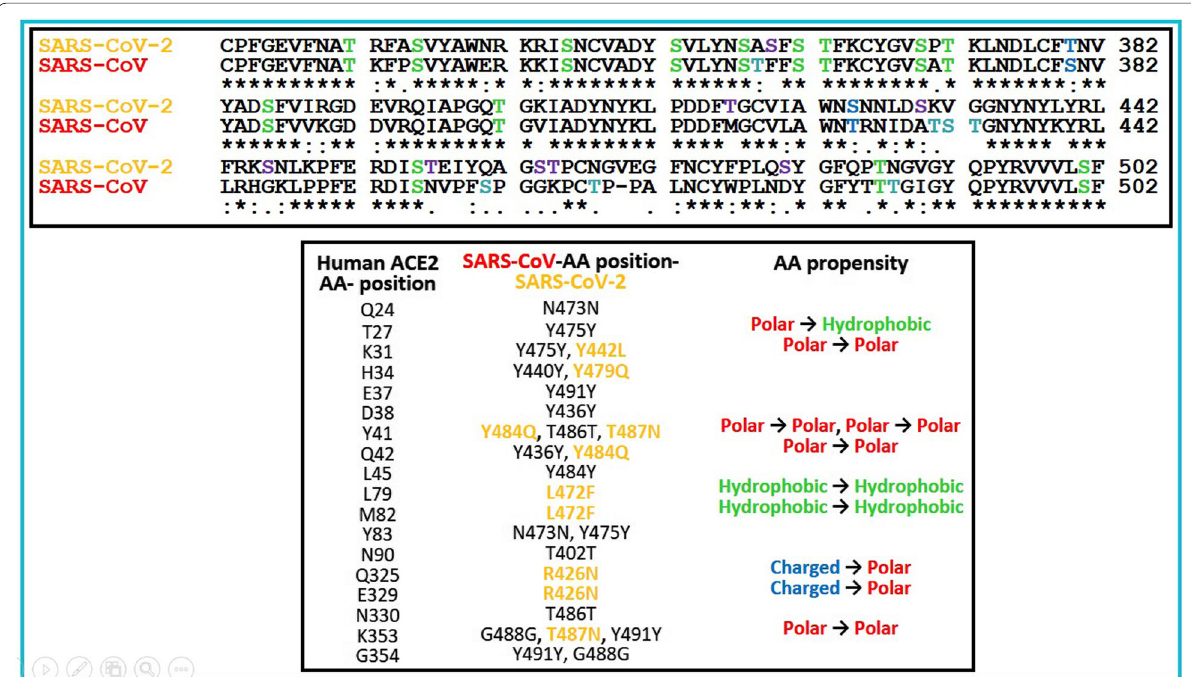
Fig. 3 Sequence alignments and characterization of SARS-CoV-2 RBD. a Amino acid alignment for RBD of SARS-CoV-2 and SARS-CoV. Highlighted residues: green, conserved Ser/Thr between two sequences; blue, conserved substitution; pink, new Ser/ Thr residues introduced in SARS-CoV-2; sea green, Ser/Thr residues in SARS-CoV replaced by other amino acids in SARS-CoV-2. b Detailed binding interface of predicted SARS-CoV-2 RBD with ACE2 N-terminal. Possible changes in AAs are highlighted in